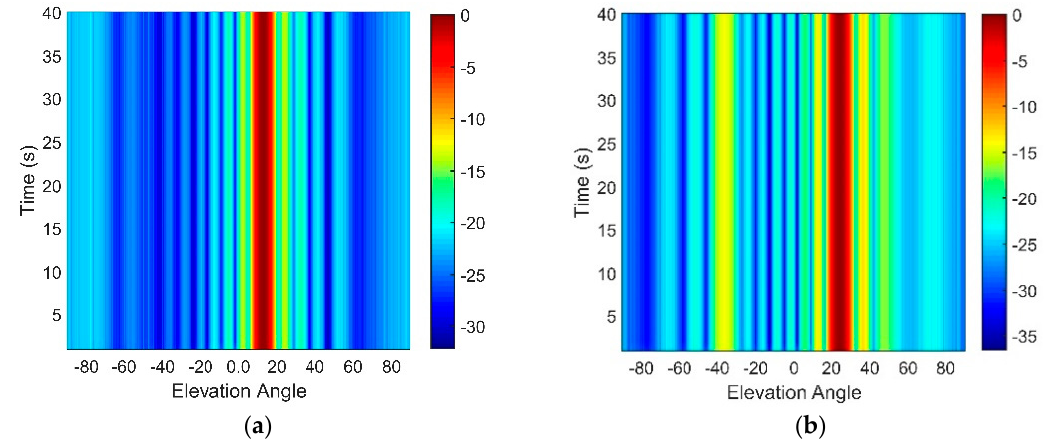
Figure 4. Beam output of a vertical line array at a depth of ( a ) 800 m and ( b ) 3800 m.